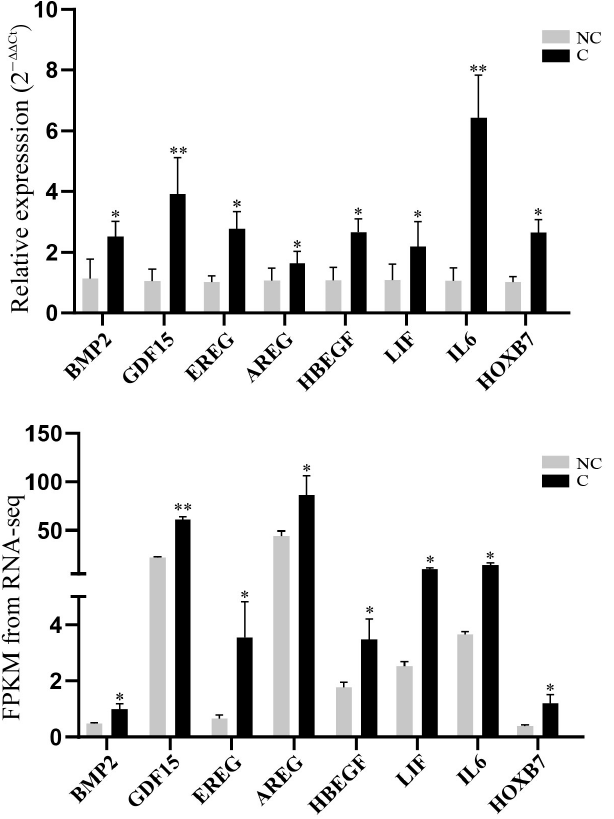
Figure 6. The expression pa tt erns of DEGs detected by qRT-PCR ( A ) and RNA-sequencing analysis ( B ). “*” and “**” represent adjusted p < 0.05 and adjusted p < 0.01, respectively. The error bars were generated based on standard deviation.